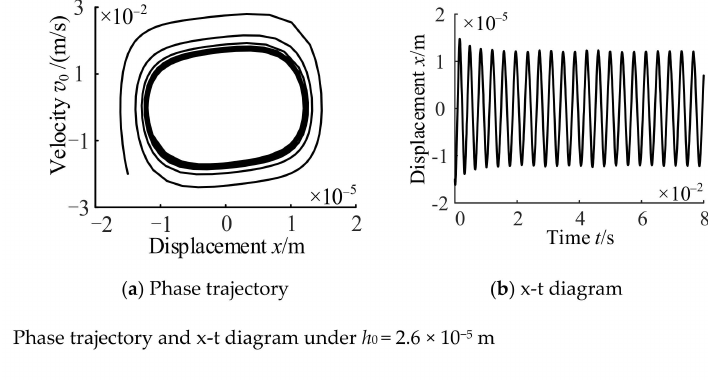
4.1.2. Phase Trajectories and X-T Diagrams under The Influence of Oil Film Thickness The initial displacement x 0 and velocity v 0 were selected, and the phase trajectory and x-t diagram were simulated, as shown in Figure 9.